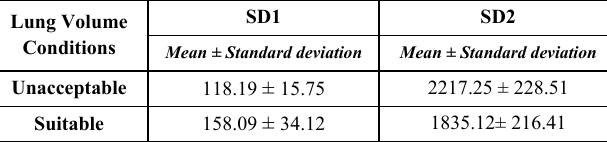
TABLE 3: The average and the standard deviation of the SD 1 and SD 2 parameters with τ = 3.